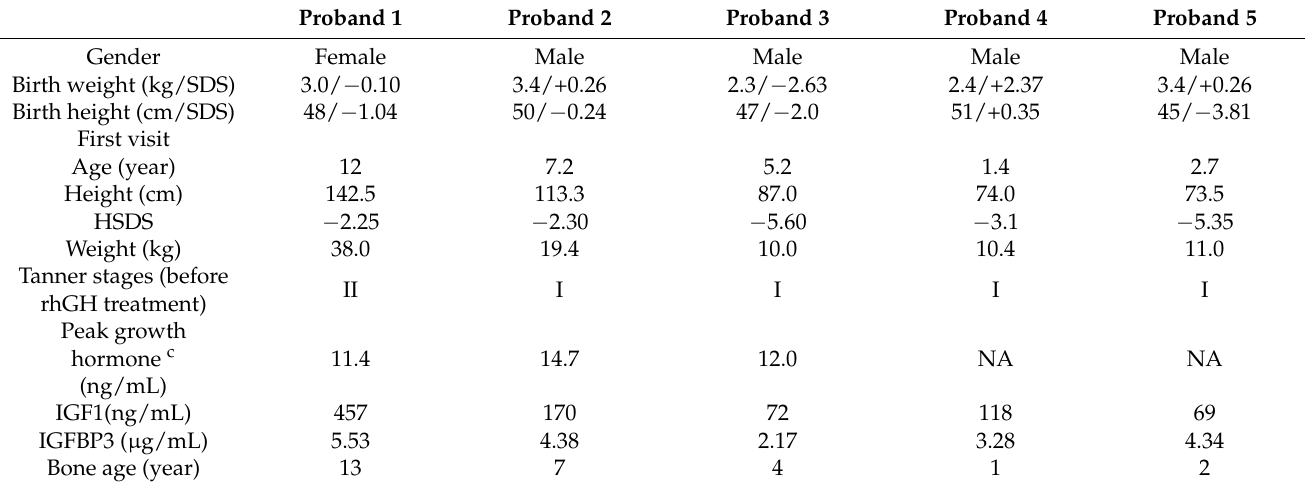
Table 1. Patient characteristics and their responses to rhGH